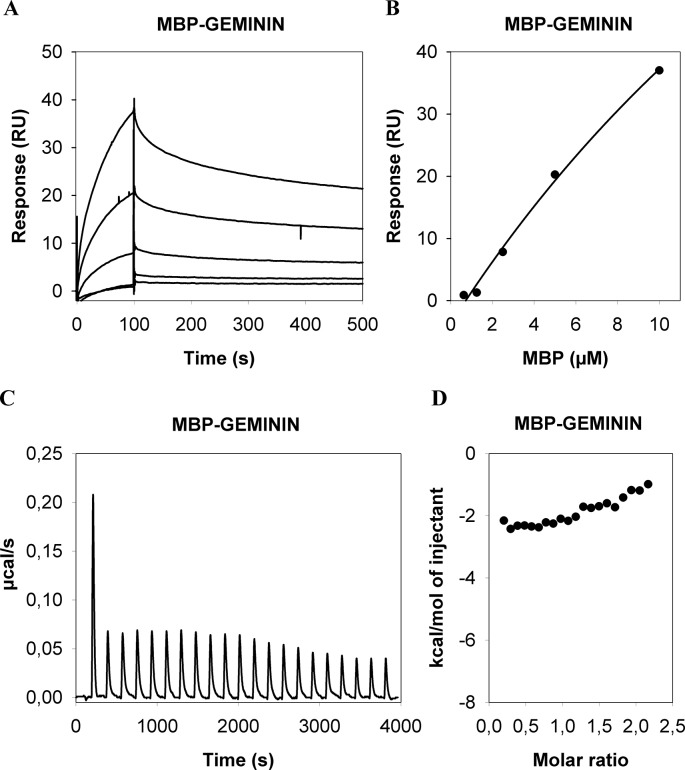
SPR and ITC analysis of MBP with GEMININ. A) MBP-GEMININ Sensorgram. MBP, at varying concentrations of 0.62 μM, 1.25 μM, 2.5 μM, 5 μM, 10 μM, was injected into the GEMININ-containing flow cell and the reference flow cell for 100 s. B) MBP-GEMININ binding affinity curve: KD: 35.3 μM, Rmax: 185.3, Chi2 (RU2): 2.6. C) ITC titration profiles of MBP-GEMININ. Titration profiles were obtained by successive addition of GEMININ to MBP. B) Binding analysis MBP-GEMININ. No binding was observed.